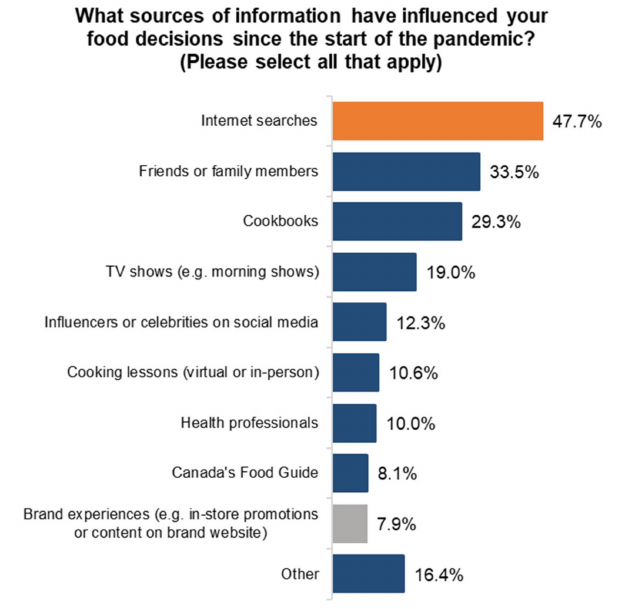
Figure 6. Sources of information for food